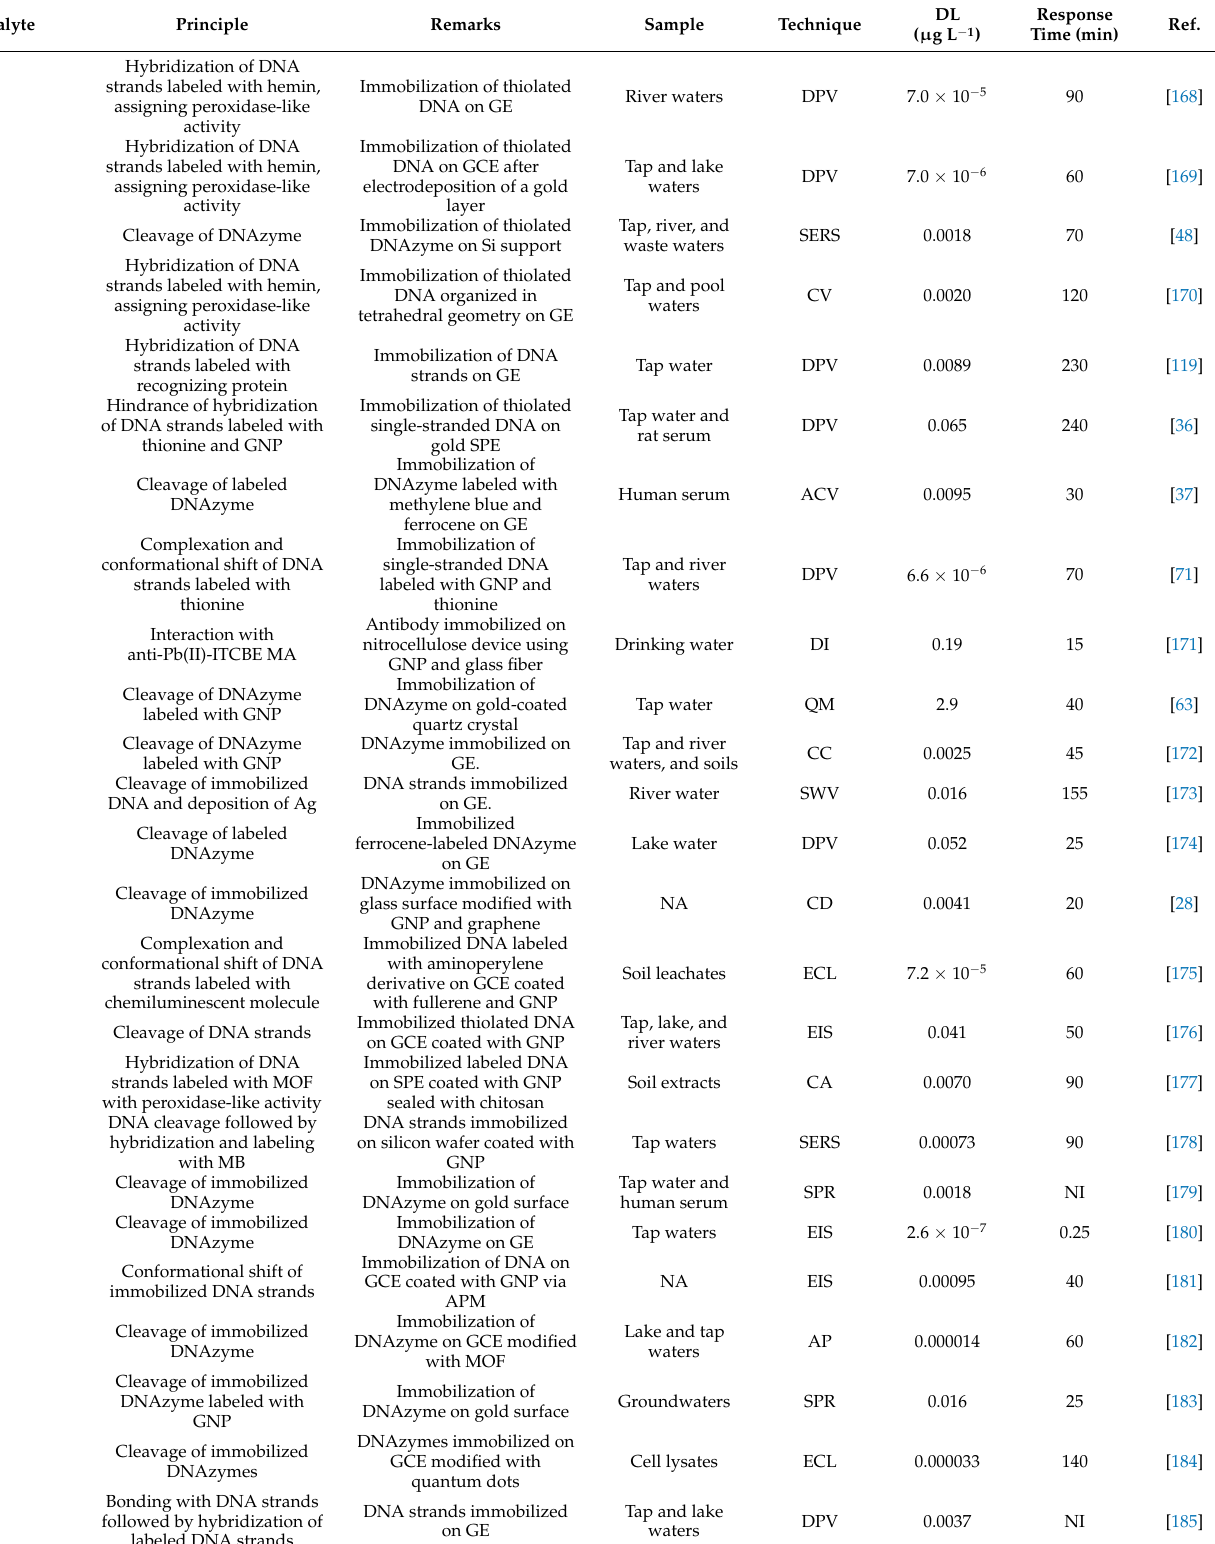
DNA strands immobilized on